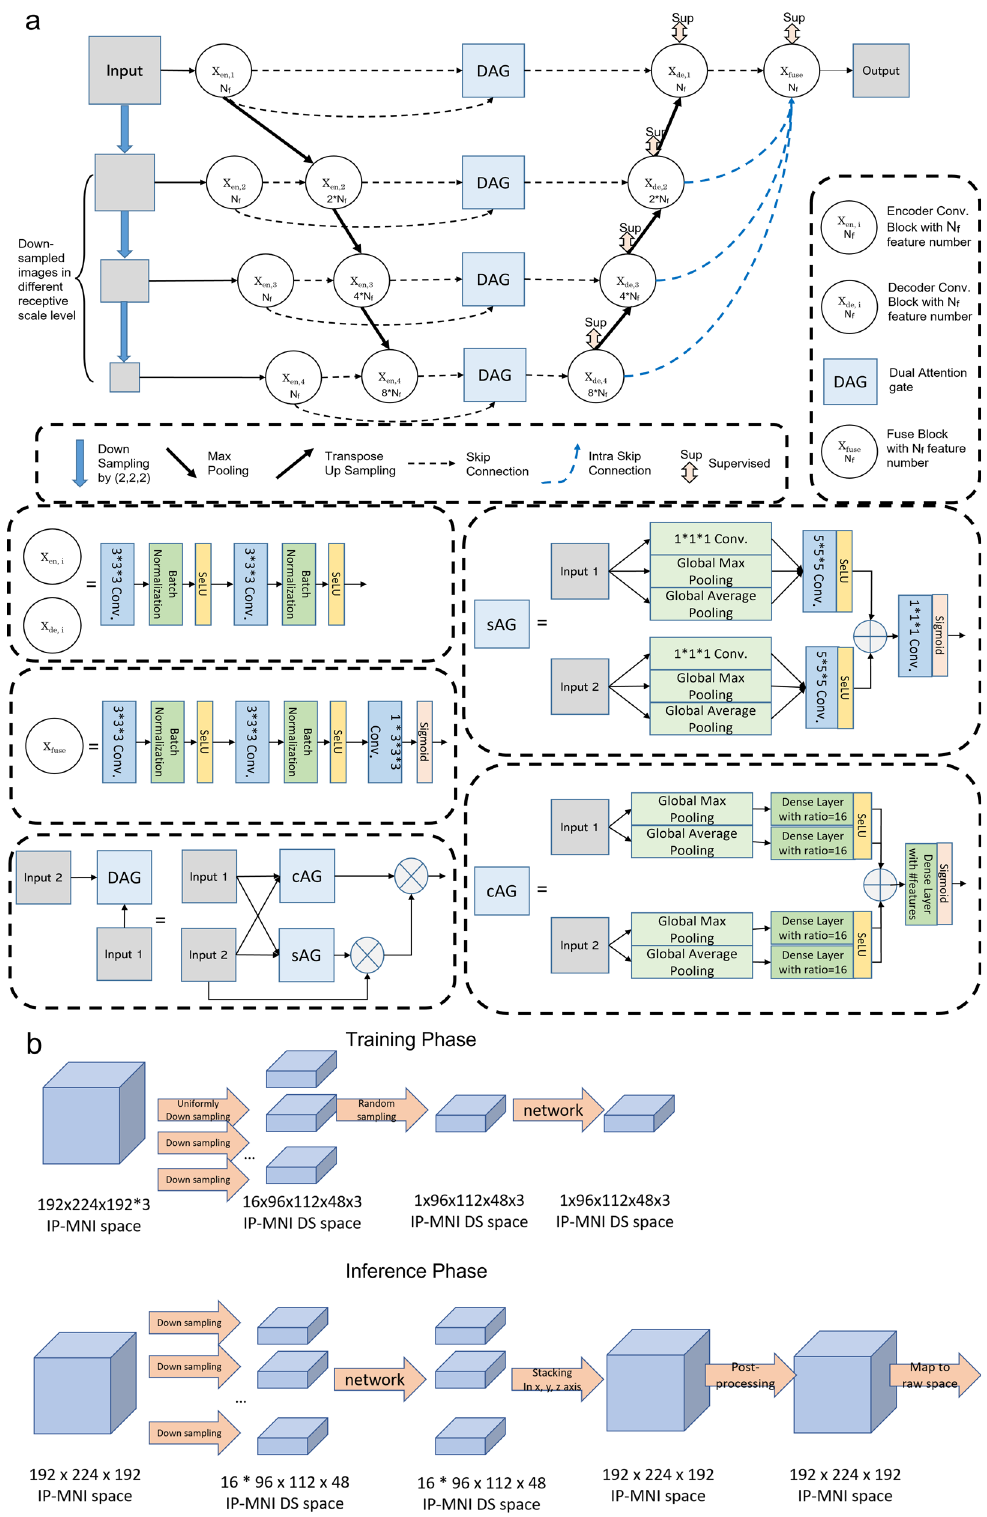
Fig. 2 Our proposed model for lesion detection and segmentation. a The architecture of the DAGMNet. In DAG, sAG stands for spatial attention gate and cAG stands for channel attention gate. “ N f " denotes the number features ( N f = 32 for our fi nal deployed DAGMNet). b Flowchart of the input image ’ s dimension for training networks and fl owchart of the lesion predict ’ s dimension for inferencing networks in IP-MNI (high-resolution) space.